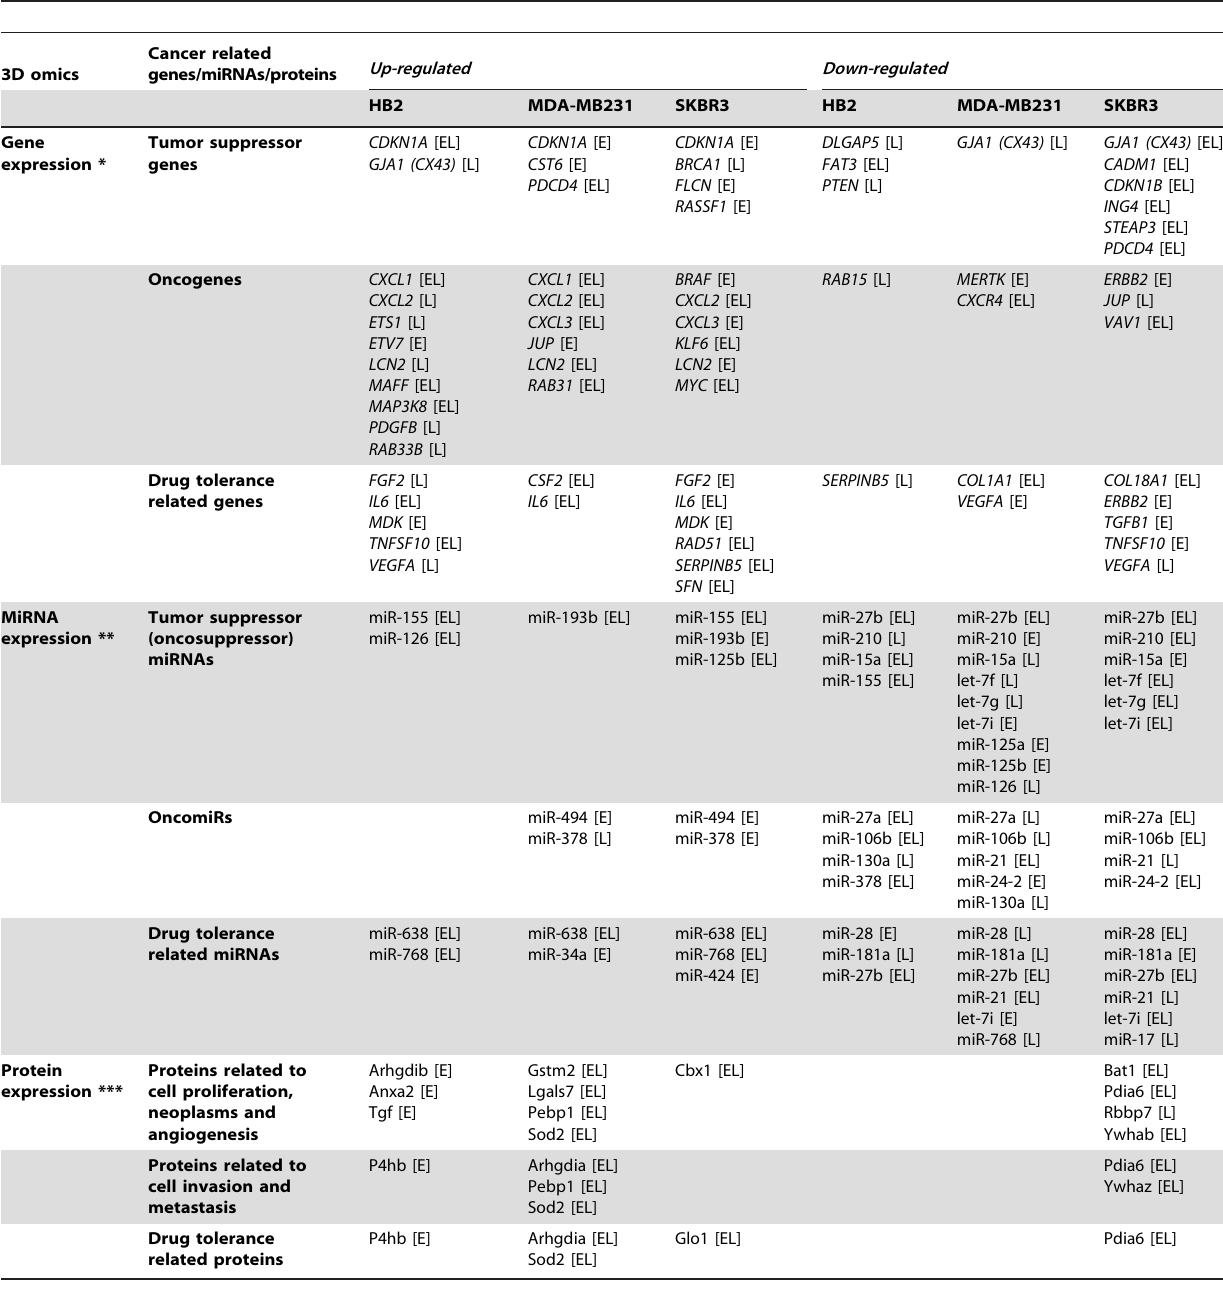
Table 2. Differentially expressed well-known cancer and/or drug tolerance related TSGs, oncogenes, miRNAs and proteins after DAC treatment in breast